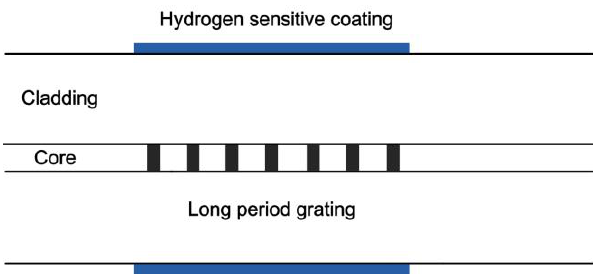
Figure 4. Typical structure of a long-period fiber grating (LPFG) hydrogen sensor [29].